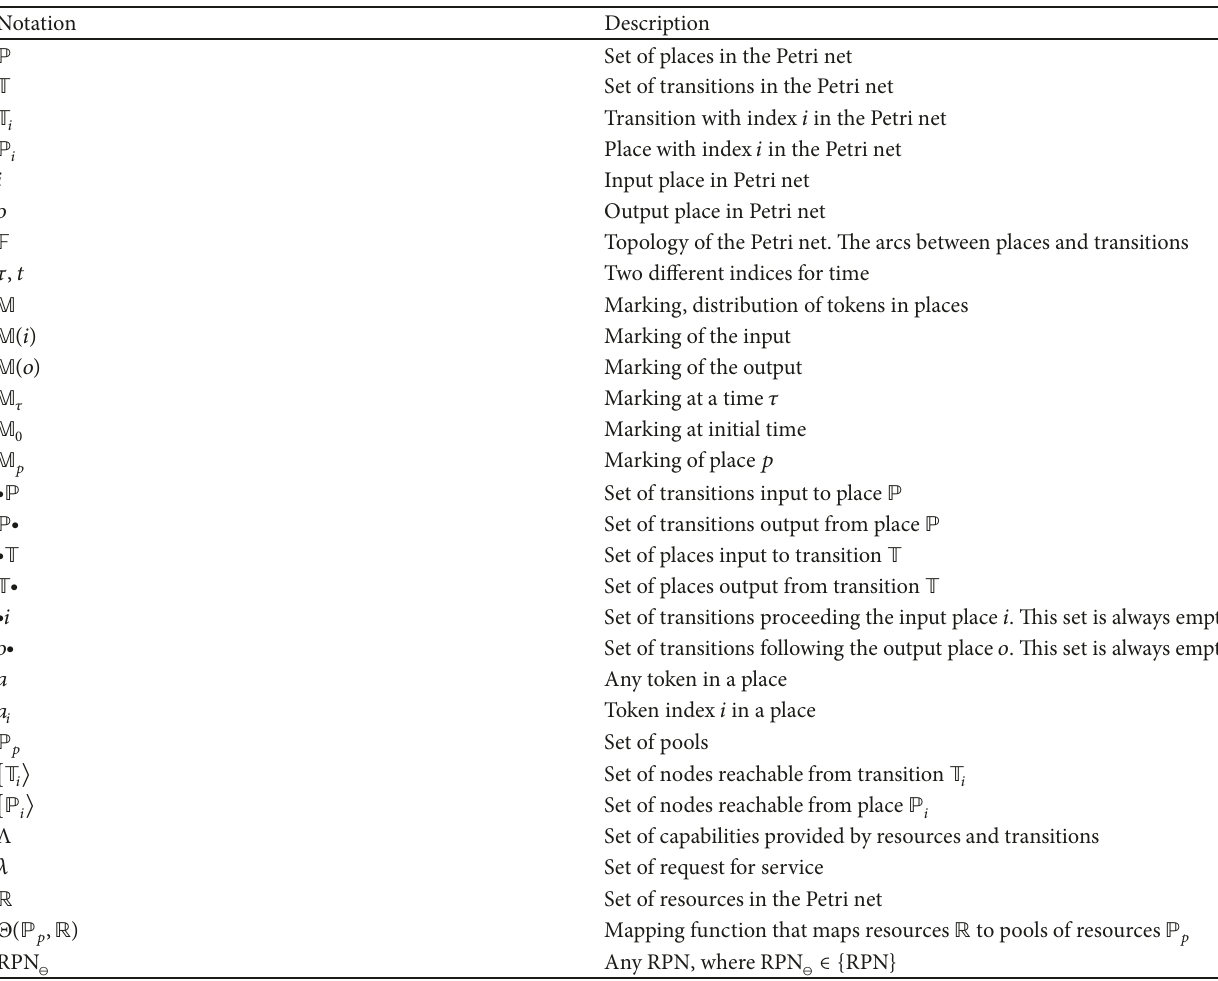
Table 1: Mathematical